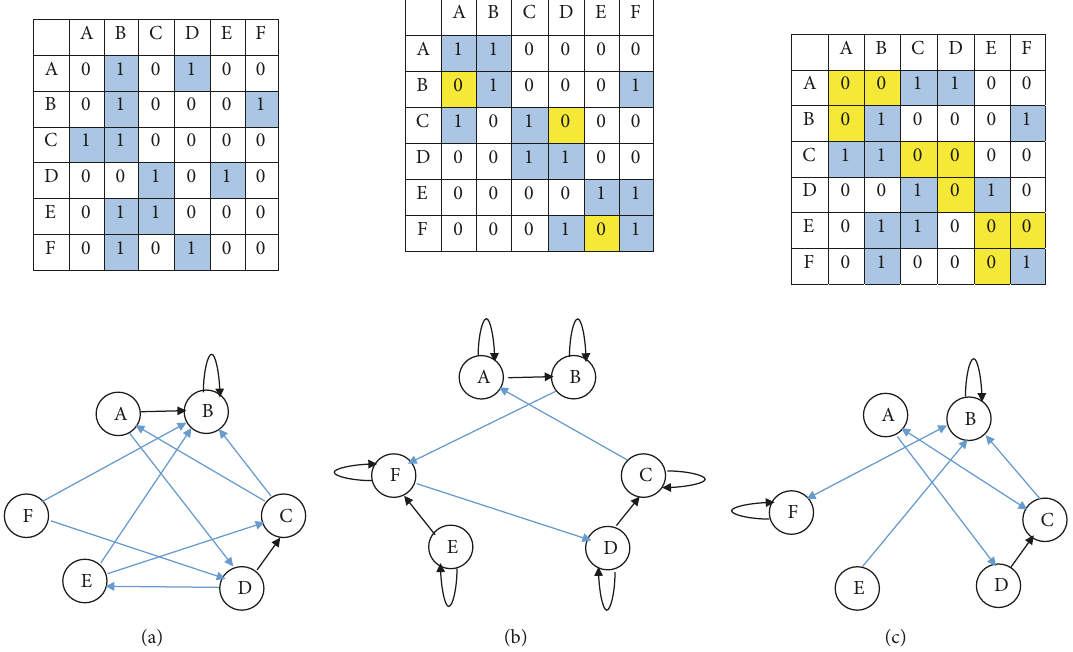
Figure 2: Adjacency matrixes and networks of standard, modular, and antimodular RBNs. All the networks consist of 6 nodes ( N = 6) and 12 links. In the network, each node has two input nodes on average ( K = 2). In the adjacency matrixes, blue means that there is a link between corresponding nodes, and yellow represents that there is no link in the defined module. (a) A standard RBN. The links are randomly distributed. (b) A modular RBN with three modules (AB, CD, and EF). There are 9 intramodular links and 3 intermodular links. (c) An antimodular RBN. The same modules as (b) are assumed. There are 3 intramodular links and 9 intermodular